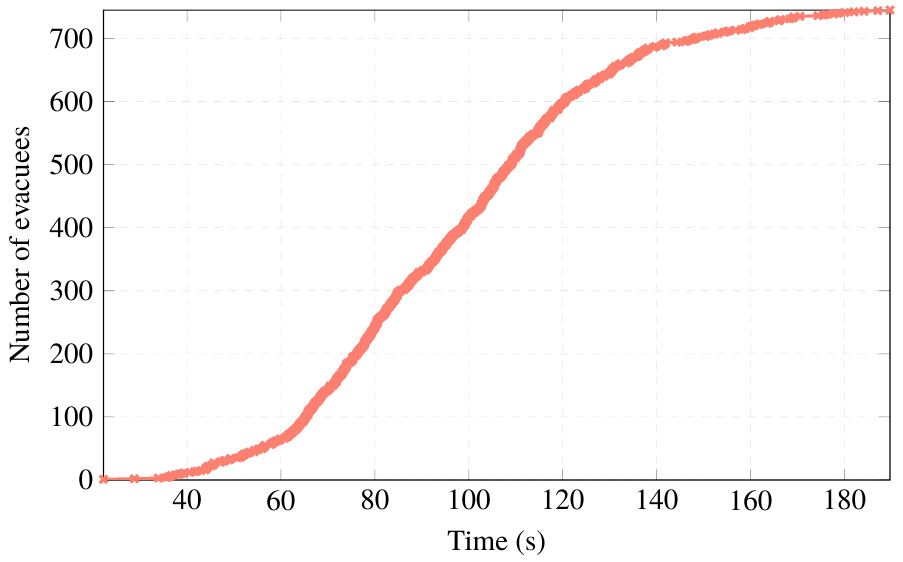
Figure 5. Dispersion diagram, time per number of evacuees (GQ situation, SIMONE).